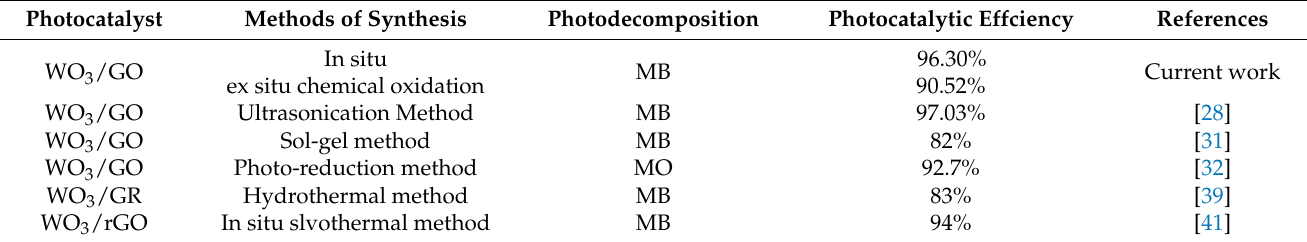
Table 2. Comparison of photocatalytic performance between this work and reported